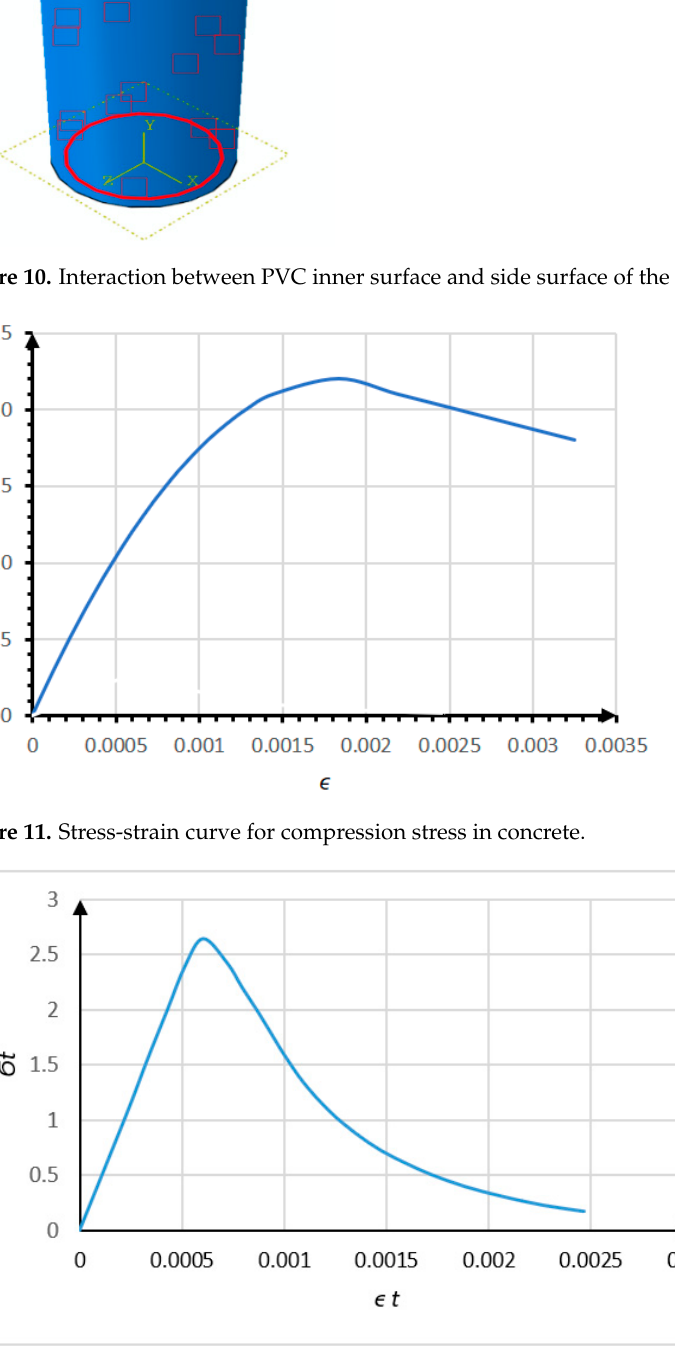
Figure 12. Stress-strain for tension stress in concrete.